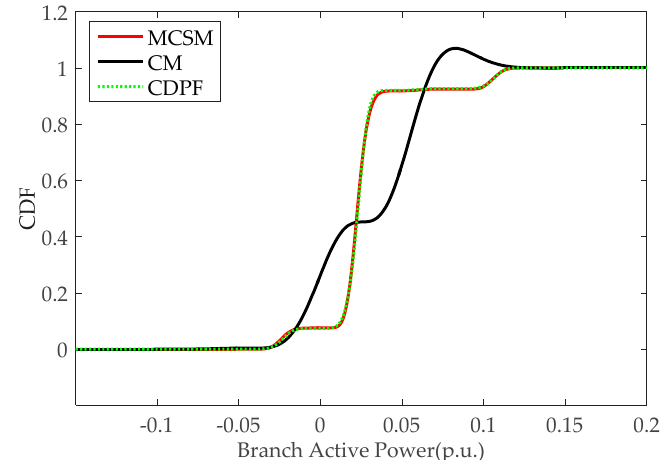
Figure 3. The probability density function (PDF) of the voltage magnitude at bus-14 in an IEEE 14-bus power system. CM: cumulant method; MCSM: Monte Carlo simulation method.